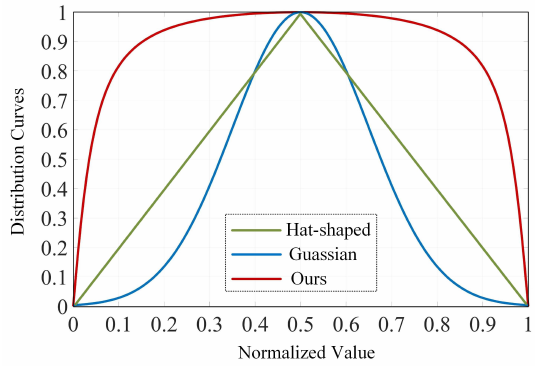
Figure 5. Comparison of three different distribution